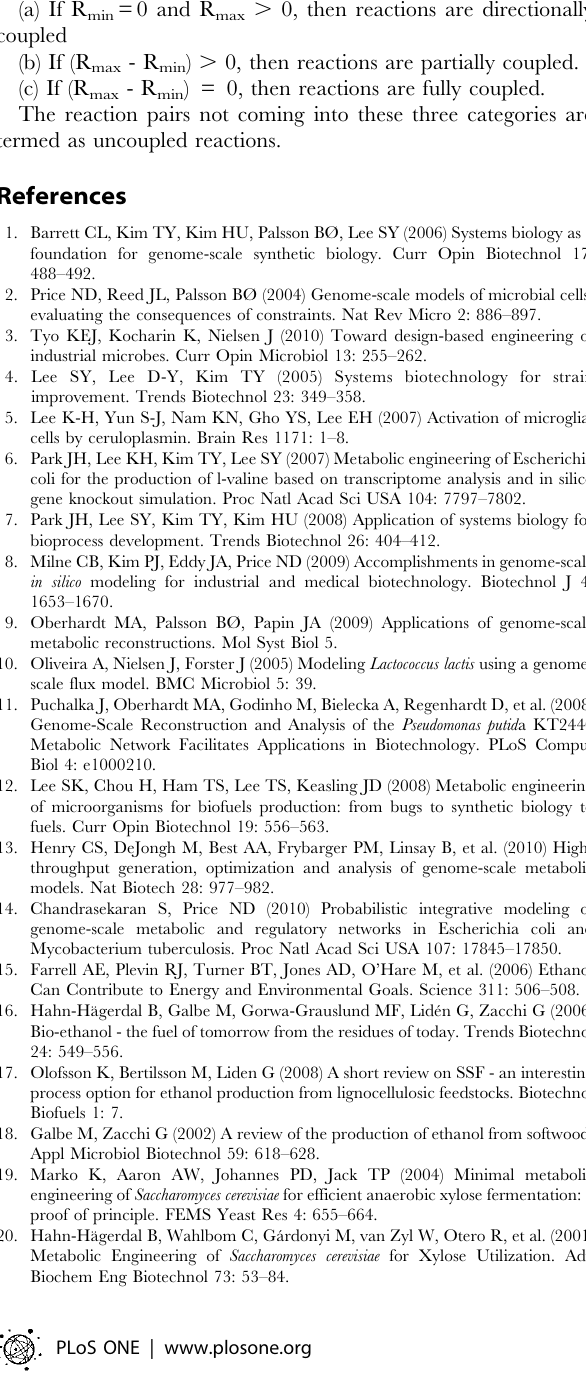
Table S1 The minimum and maximum allowable flux values obtained for reactions with different values of span change (SC), (a) Span ECI -Span ECB . 0.5, (b) 0.01 , Span ECI -Span ECB , 0.5 and (c) 0.0 , Span ECI -Span ECB , 0.01. The span change or difference of flux span between engineered cofactor imbalanced (ECI) and engineered cofactor balanced (ECB) models is given by, SC = Span ECI -Span ECB . Table S2 Based on the flux ratio limits R max (max v 1 /v 2 ) and R min (min v 1 /v 2 ) various types of coupling were identified for wild type, engineered cofactor imbalanced (ECI) and engineered cofactor balanced (ECB)